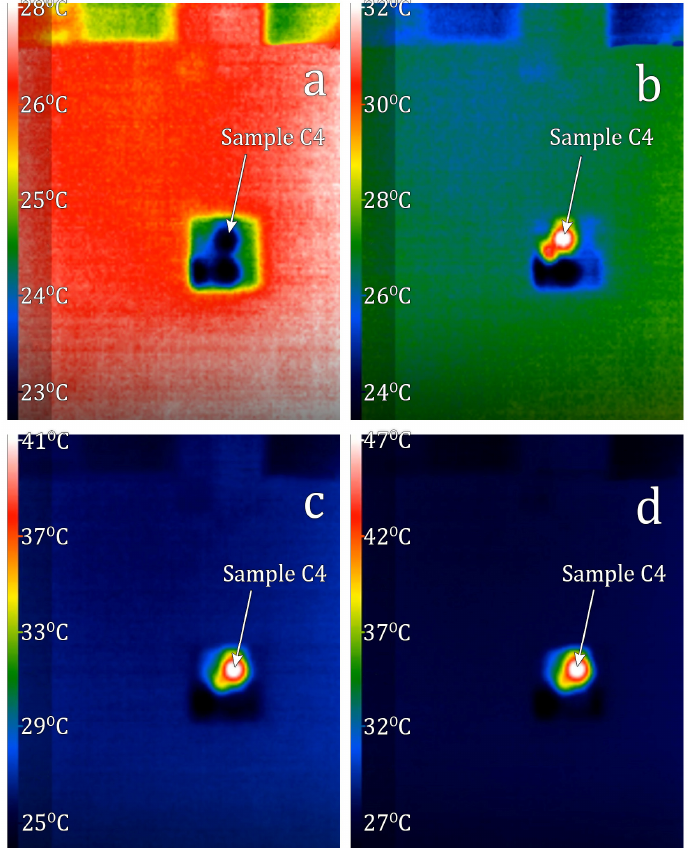
Figure 7. Temperature of sample C4 as time function: ( a )—0 min.; ( b )—1 min.; ( c )—2 min.; ( d )—3 min. Table 5. Magnetic hyperthermia of the SrFe 12 − x In x O 19 sample C4 (x = 1.7), obtained by the